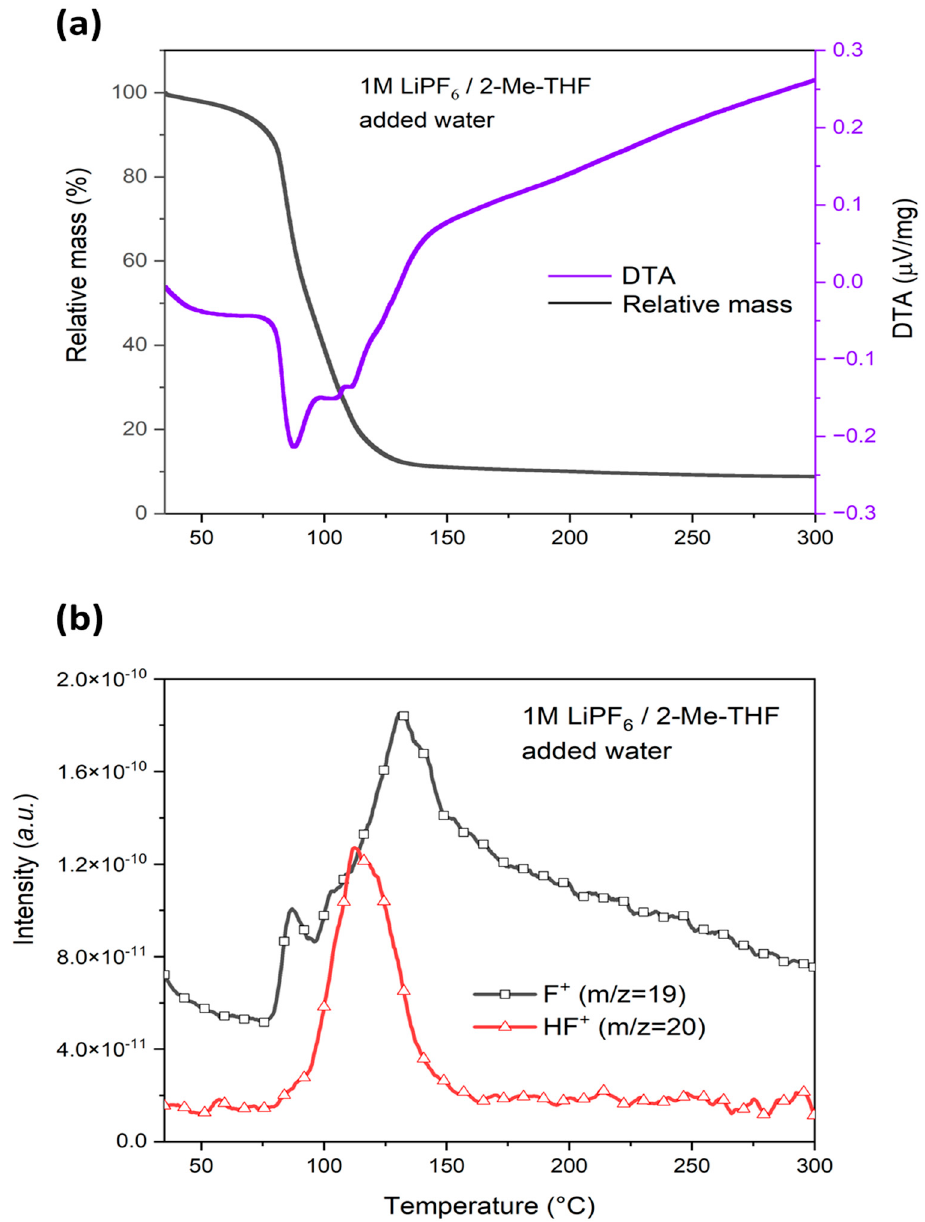
Figure 8. ( a ) TG/DTA curves of HF generation temperature in 1 M LiPF 6 /2-ME-THF electrolyte solution with added water, and ( b ) the simultaneous F + and HF + identification using MS.